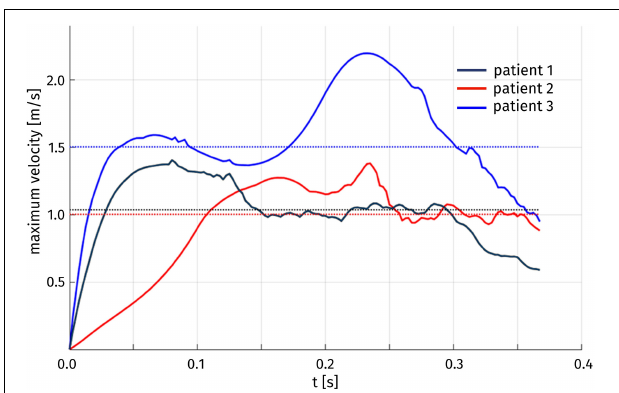
FIGURE 8 | Time evolution of the maximum blood velocity U(t) over the whole aorta. The median U thr of U(t) over time for each patient is indicated by a dotted